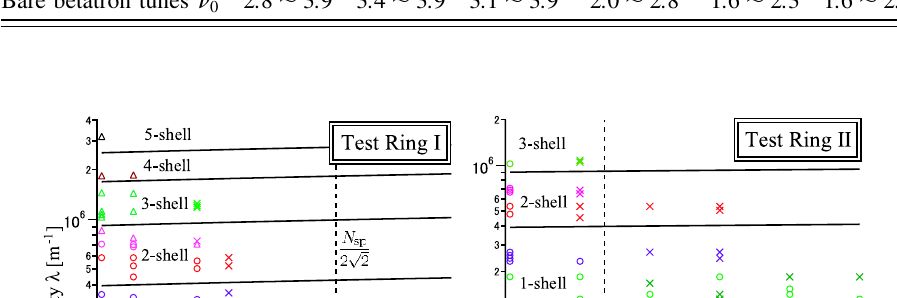
p (cid:2) N = 2 (cid:1)(cid:1)(cid:1) 2 0 sp